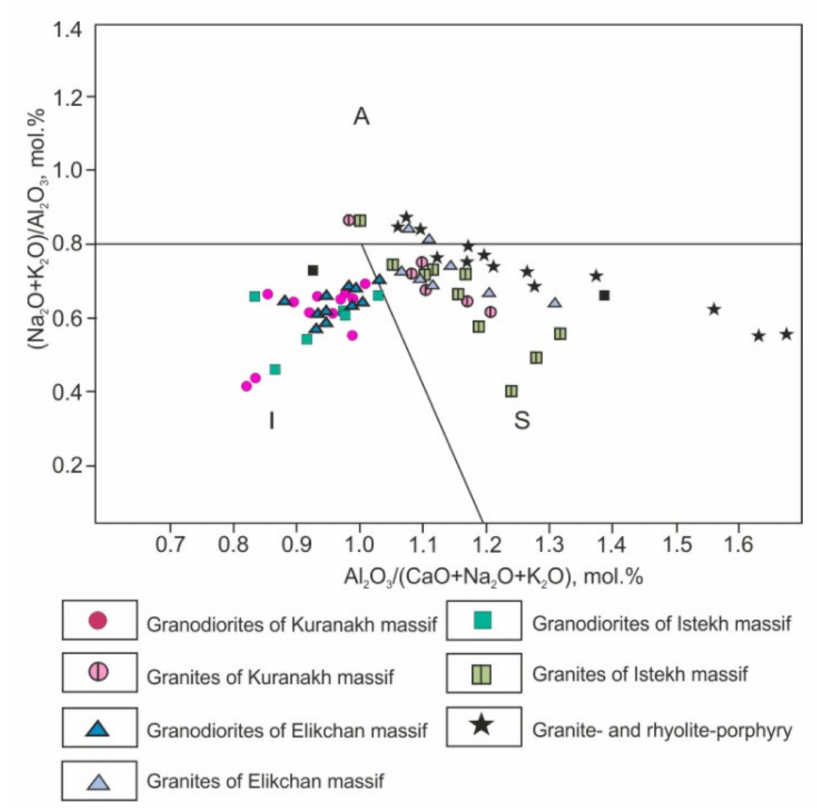
Figure 17. (Na 2 O + K 2 O)/Al 2 O 3 –Al 2 O 3 /(CaO + Na 2 O + K 2 O) diagram for granitoids. Fields on the diagram are derived from